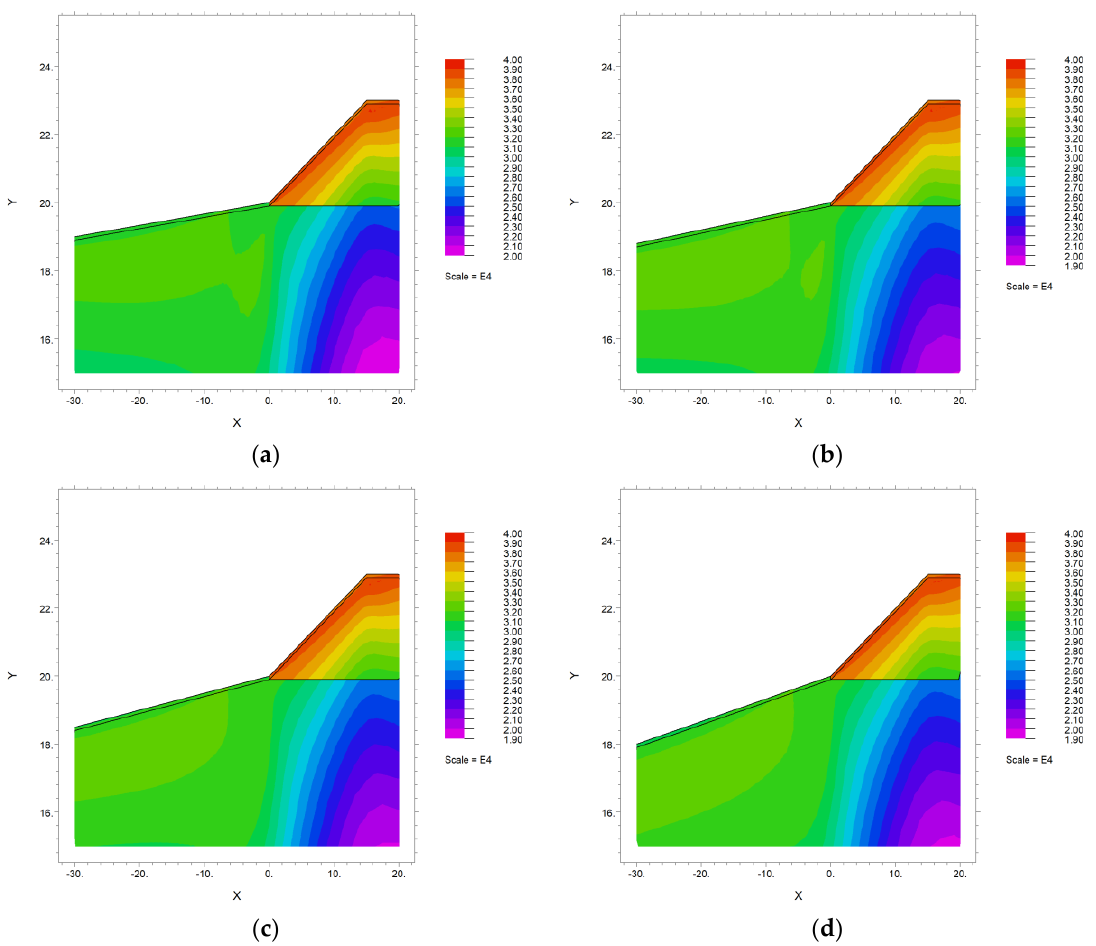
Figure 7. Coulomb – Mohr potential for the clay-type subsoil, for underwater slope inclinations of ( a ) 1:30, ( b ) 1:25, ( c ) 1:20, ( d ) 1:15 (negative values indicate compressive stresses in Pa, and positive values — tensile stresses in Pa).